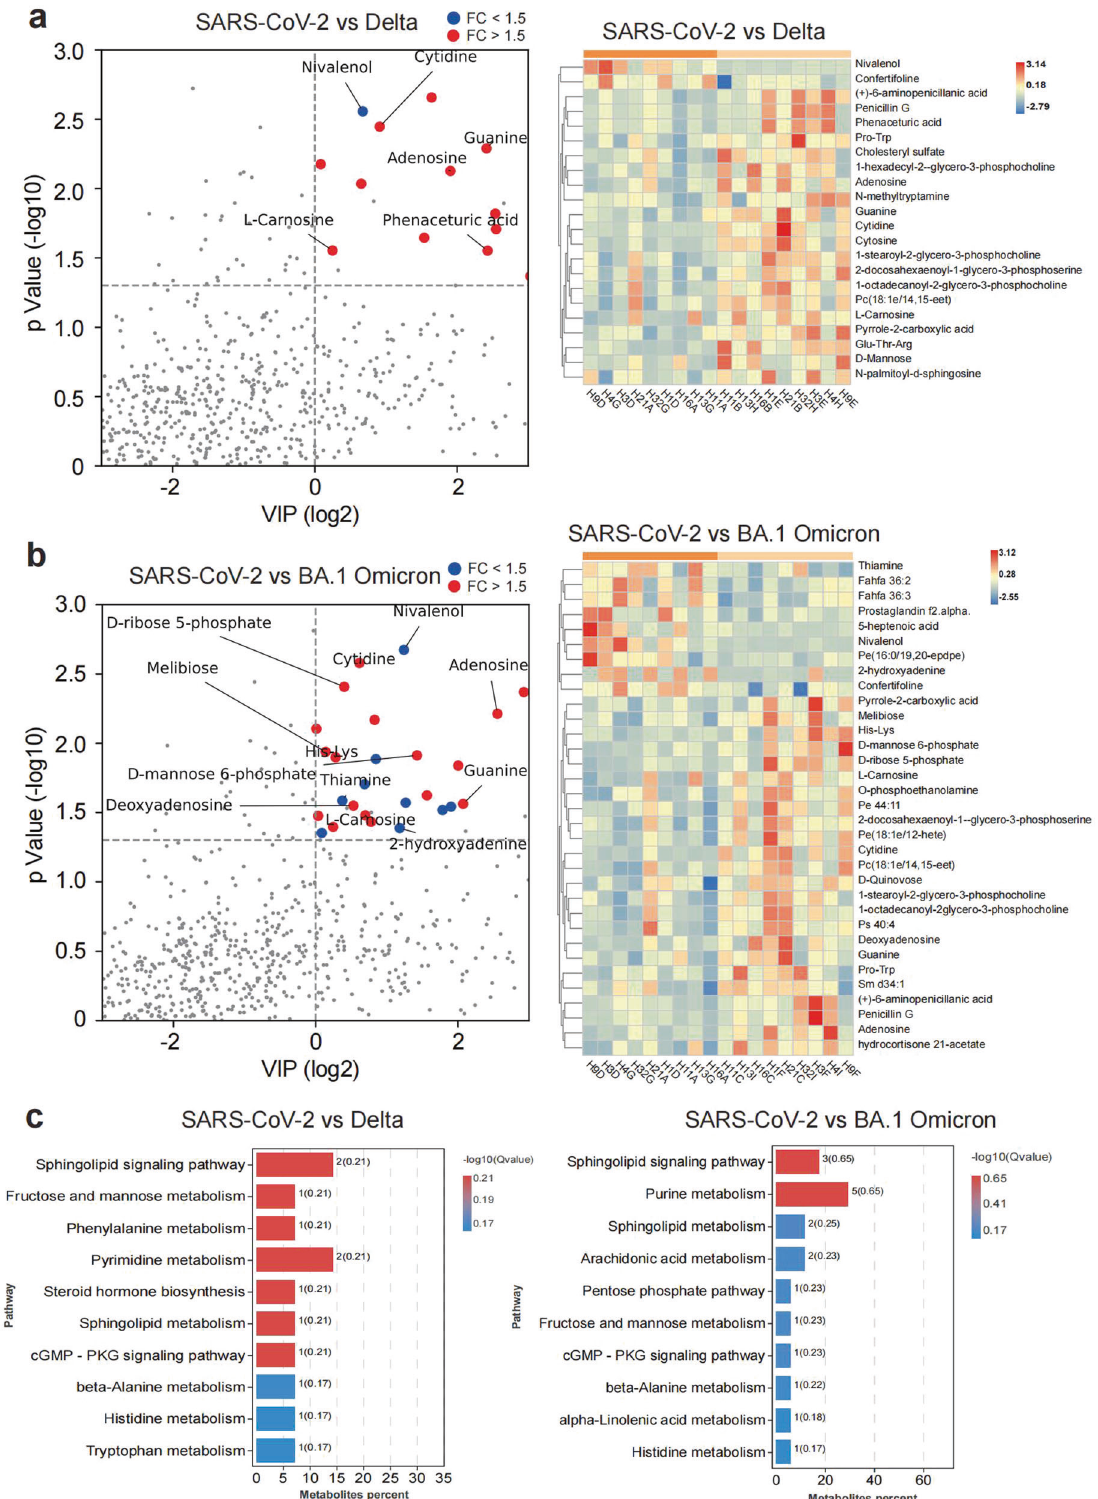
Fig. 3 Metabolic pro fi ling of SARS-CoV-2, Delta or Omicron-speci fi c CD8 + T cells from 3-dose vaccinees. a The differential metabolic pro fi ling of Delta vs SARS-CoV-2. b The differential metabolic pro fi ling of BA.1 Omicron vs SARS-CoV-2. c KEGG analysis of difference metabolites of SARS-CoV-2 vs Delta, and SARS-CoV-2 vs Omicron, from 3-dose vaccinees. Data are represented as mean ± SEM